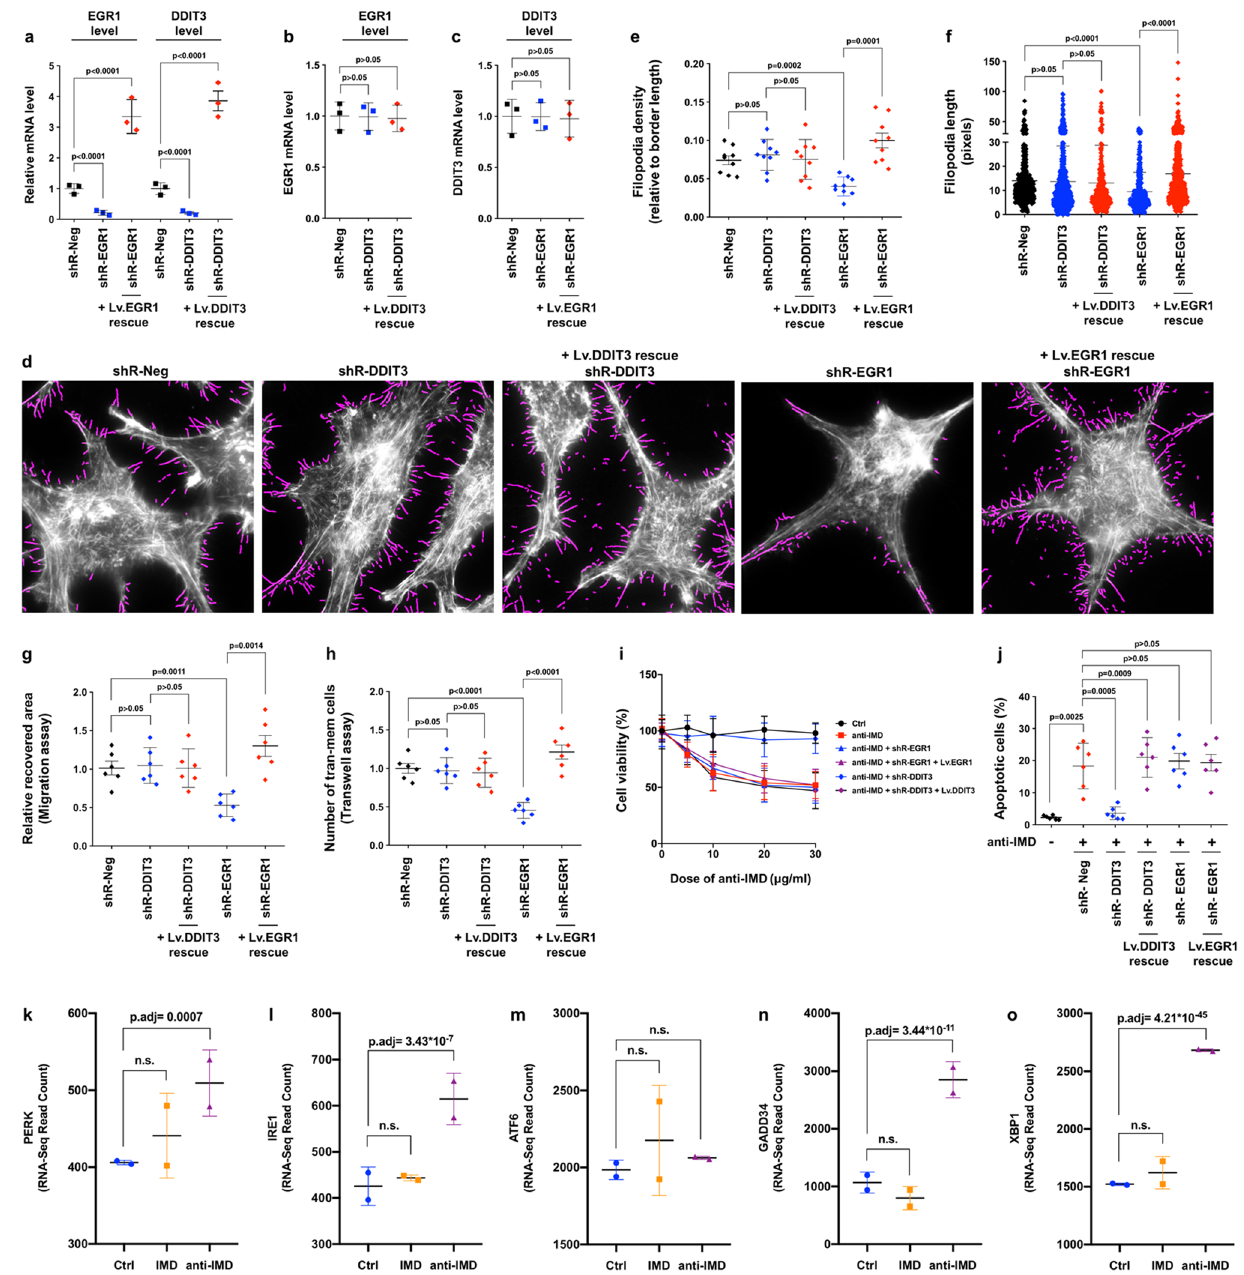
Figure 7. EGR1 and DDIT3 were responsible for the effect of IMD on HCC cells. ( a ) The HCC-15H cells were transfected with shRNAs that target the 3 ′ UTR region of EGR1 or DDIT3 (with or without Lv. EGR1 an Lv. DDIT3 rescuing). After 48 h, the mRNA levels of EGR1 or DDIT3 was measured using Real-time PCR. ( b , c ) The mutual effects between EGR1 and DDIT3 by measuring the mRNA level of EGR1 or DDIT3 under the condition of another gene being knockdown or overexpression (n = 3). ( d ) The HCC-15H cells transfected with shRNA-EGR1, shRNA-DDIT3 (with or without Lv. EGR1 an Lv. DDIT3 rescuing) were stained by AlexaFluo568-phalloidin and analyzed using FiloQuant. ( e , f ) The filopodia density and length were measured using 10 randomly chosen fields. ( g , h ) The cell migration and invasion ability were measured using Wound healing assay and Transwell assay (n = 6). ( i , j ) Before the HCC-15H cells were treated by different dose of anti- IMD, the cells were transfected with shRNA-DDIT3 or shRNA-EGR1 (with or without Lv. EGR1 an Lv. DDIT3 rescuing), and the cell viability ( i ) and apoptosis was measured ( j ). Data were presented as scatter plots with mean ± SD (n = 6). ( k – o ) The RNA-sequencing read counts of PERK, IRE1, ATF6, GADD34, XBP1 in IMD- or anti-IMD-treated group (n = 2). Significance was assessed by unpaired t test with Welch’s correction ( a , b , c , e , g , h , j ), Mann–Whitney u test ( f ), and p.adj comparison in the RNA-Seq DEG analysis ( k – o